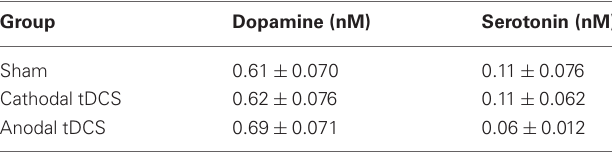
Table 1 | Absolute basal dialysis levels of dopamine and serotonin.